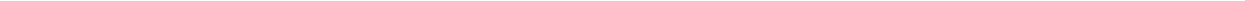
Figure 4 | Learning-dependent changes of population prediction accuracy for forelimb instantaneous velocity. ( a ) SVR decoding of forelimb velocity from neural population activities. For each neuron, the firing histogram (bin size: 12.5ms, left) was aligned to the behavioural event (27 units from an example animal), and the values was linearly normalized to 0–1 range. The actual forelimb instantaneous velocity (top right) was predicted using SVR by the corresponding population spike events. ( b ) Representative traces of actual forelimb instantaneous velocity (black) and the SVR model predicted forelimb velocity (red) by three types of neurons classified (type 1 neuron: n ¼ 4; type 2 neuron: n ¼ 12; type 3 neuron: n ¼ 11, from an example animal), illustrating the changes in population decoding accuracy during early (day 1) and late (day 7) training sessions. ( c ) Least squares regression analyses between actual forelimb instantaneous velocity and the SVR model predicted forelimb velocity based on three types of L5b PNs shown in a during early and late training sessions. The Pearson’s correlation coefficient ( r 2 ) and mean squared deviation (MSD) for each regression are shown. Each data point represents the instantaneous velocity of the forelimb trajectory predicted from neural population activity versus the actual velocity of displacement calculated from high-speed camera recording (in 12.5ms bins). ( d ) Summarized result of r 2 and MSD of predicted and actual forelimb instantaneous velocity by three types of PNs ( n ¼ 131) recorded from five rats. Upper left panel, day 1: r 2 ¼ 0.513 ± 0.013, day 3: r 2 ¼ 0.505 ± 0.010, P ¼ 0.098; day 7: r 2 ¼ 0.520 ± 0.013, P ¼ 0.492; bottom left panel, day 1: MSD ¼ 0.0069 ± 0.00043, day 3: MSD ¼ 0.0073 ± 0.00028, P ¼ 0.370; day 7: MSD ¼ 0.0072 ± 0.00033, P ¼ 0.448.